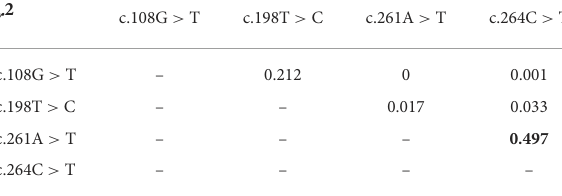
TABLE 2 Linkage disequilibrium (LD) analysis of 4 PRNP polymorphisms of raccoon